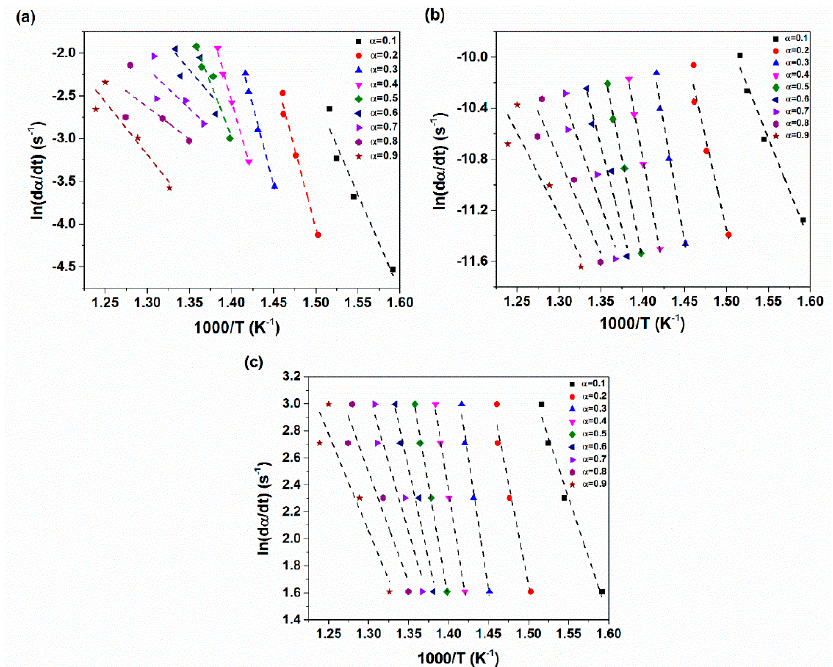
Figure 13. Typical isoconversional graphs for XNBR/epoxy/XHNT nanocomposites through using ( a ) Friedman ( b ) Kissinger–Akahira–Sunose (KAS) ( c ) Ozawa-Flynn–Wall (OFW) methods.